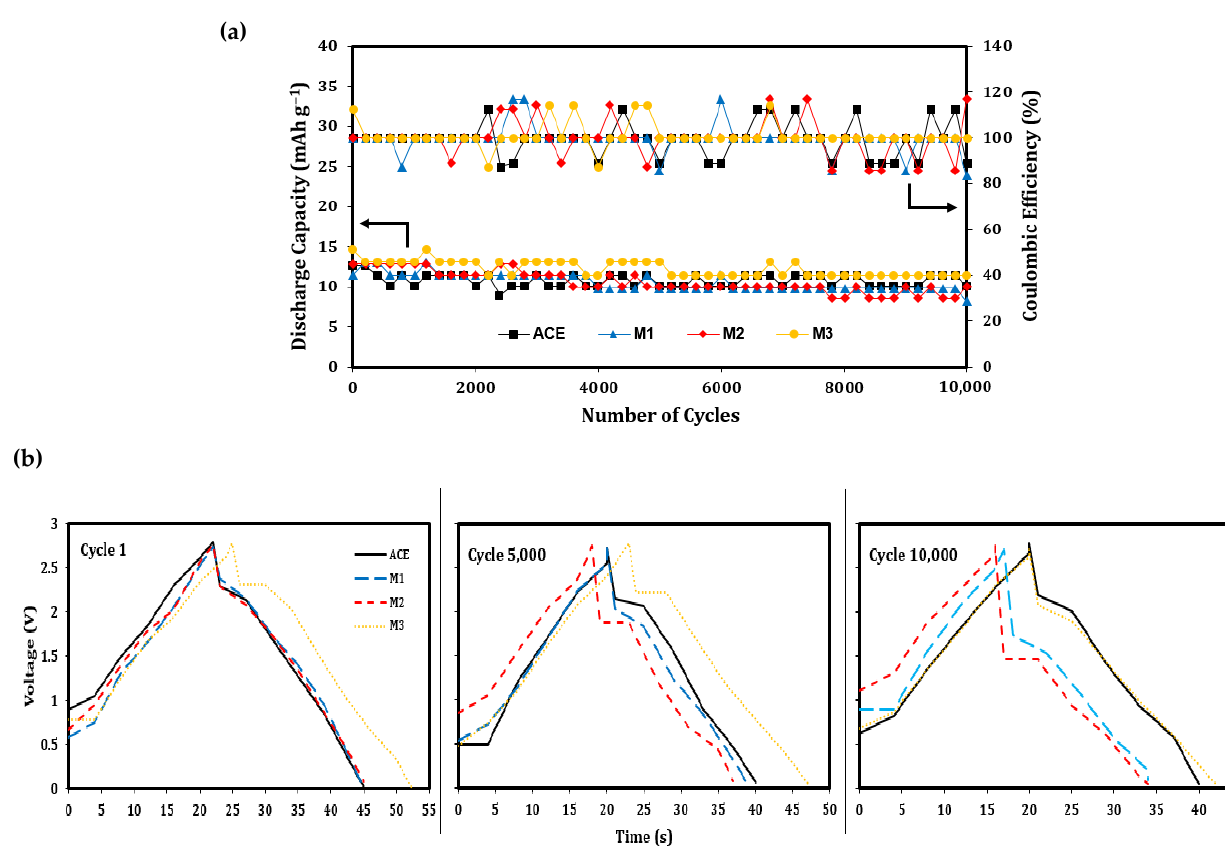
Figure 8. Long-term cyclic stability performance ( a ) and voltage–time curves of cycles 1, 5k, and 10k ( b ) of ACE, M1, M2, and M3. Table 3. Output linear trend line values for 10,000 cycles